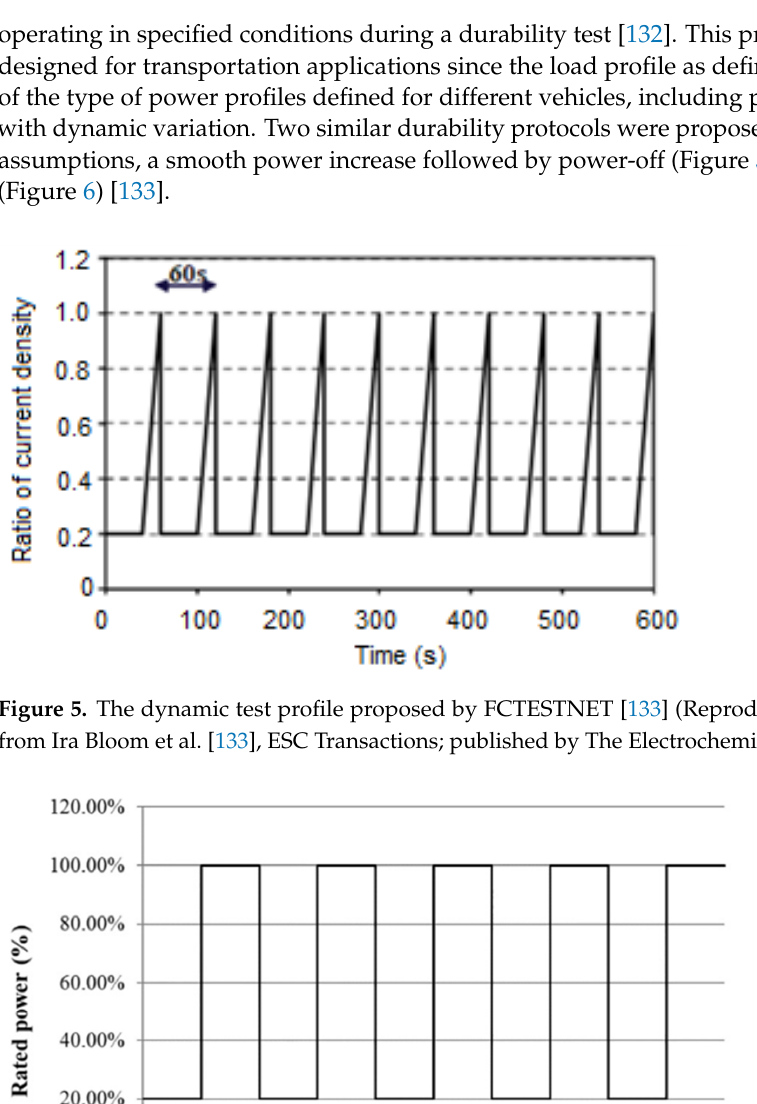
and Standardization Network (FC TestNet) [120] (Reproduced with permission from Ira Bloom et al. [119], Journal of Power Sources; published by Elsevier B.V, 2013).